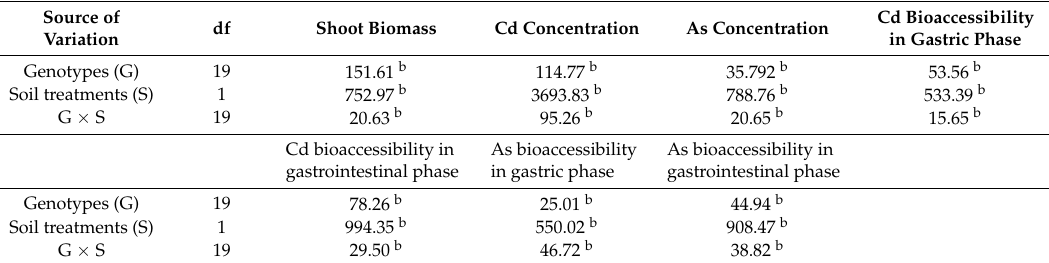
Table 2. Analysis of variance for shoot biomass, Cd concentration, As concentration, Cd bioaccessibility in gastric phase, Cd bioaccessibility in gastrointestinal phase, As bioaccessibility in gastric phase and As bioaccessibility in gastrointestinal phase, of 20 genotypes under different levels of Cd and As co-contaminated soils a .